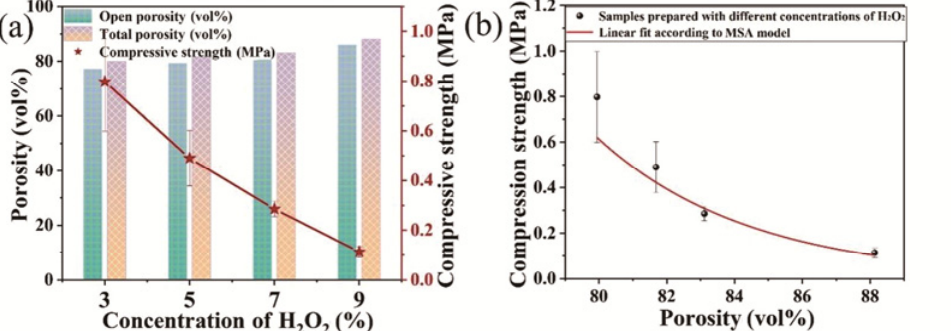
Fig. 4 (a) Compressive strength and porosity vs. concentration of H 2 O 2 and (b) porosity and strength of the samples fitted according to the minimum solid area (MSA) model.